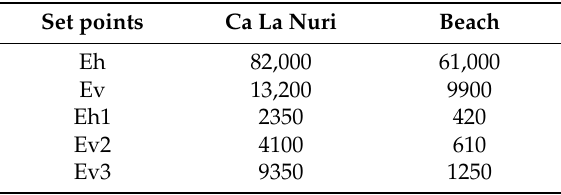
Table 2. Illuminance data (in lx) of each